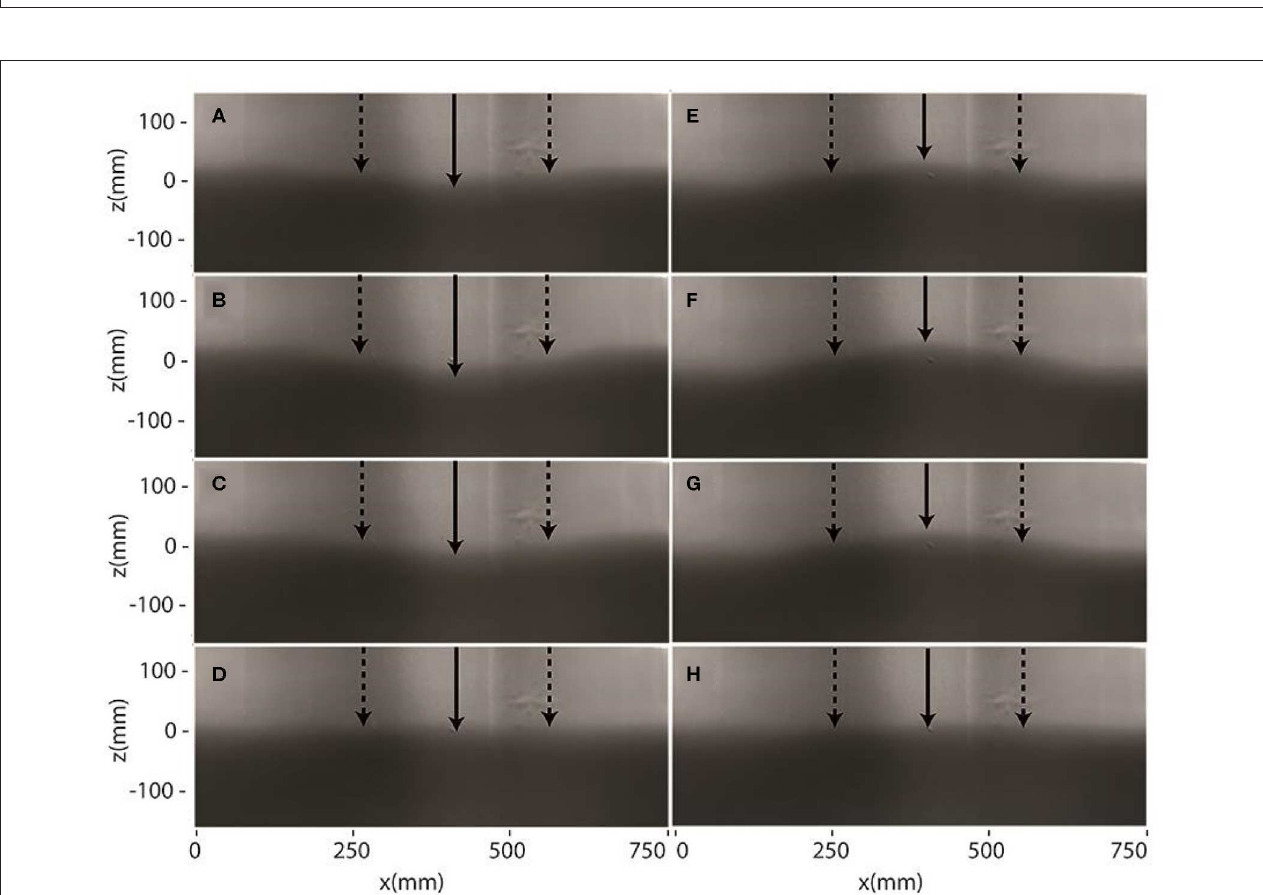
FIGURE 3 | Flow visualization showing eight phases during the wave cycle corresponding to φ = (A) 0, (B) π [radians]. The locations of the nodes are marked by the vertical dotted arrows and the antinodes are marked by the solid arrows.